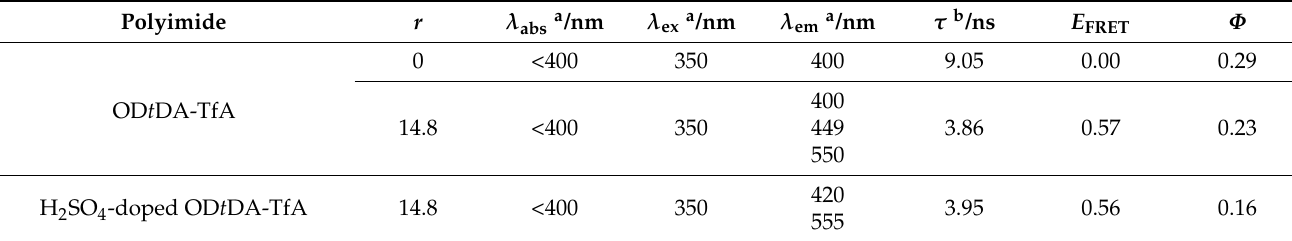
Figure 7. UV − vis absorption and emission spectra of ( a ) OD t DA-TfA and ( b ) OD t DA-TfA doped with H 2 SO 4 (0.5 eq.), which were prepared with r = 14.8, and photographs of these films under white light (UV off) and UV ( λ = 365 nm) irradiation (UV on). Table 3. Photoluminescence properties, absorption wavelengths ( λ abs ), excitation/emission wavelengths ( λ ex , λ em ), fluorescence lifetimes at 400 nm ( τ ), FRET efficiencies ( E FRET ), and quantum yields ( Φ ) of OD t DA and OD t DA-TfA with r = 14.8 without/with H 2 SO 4 doping (0.5